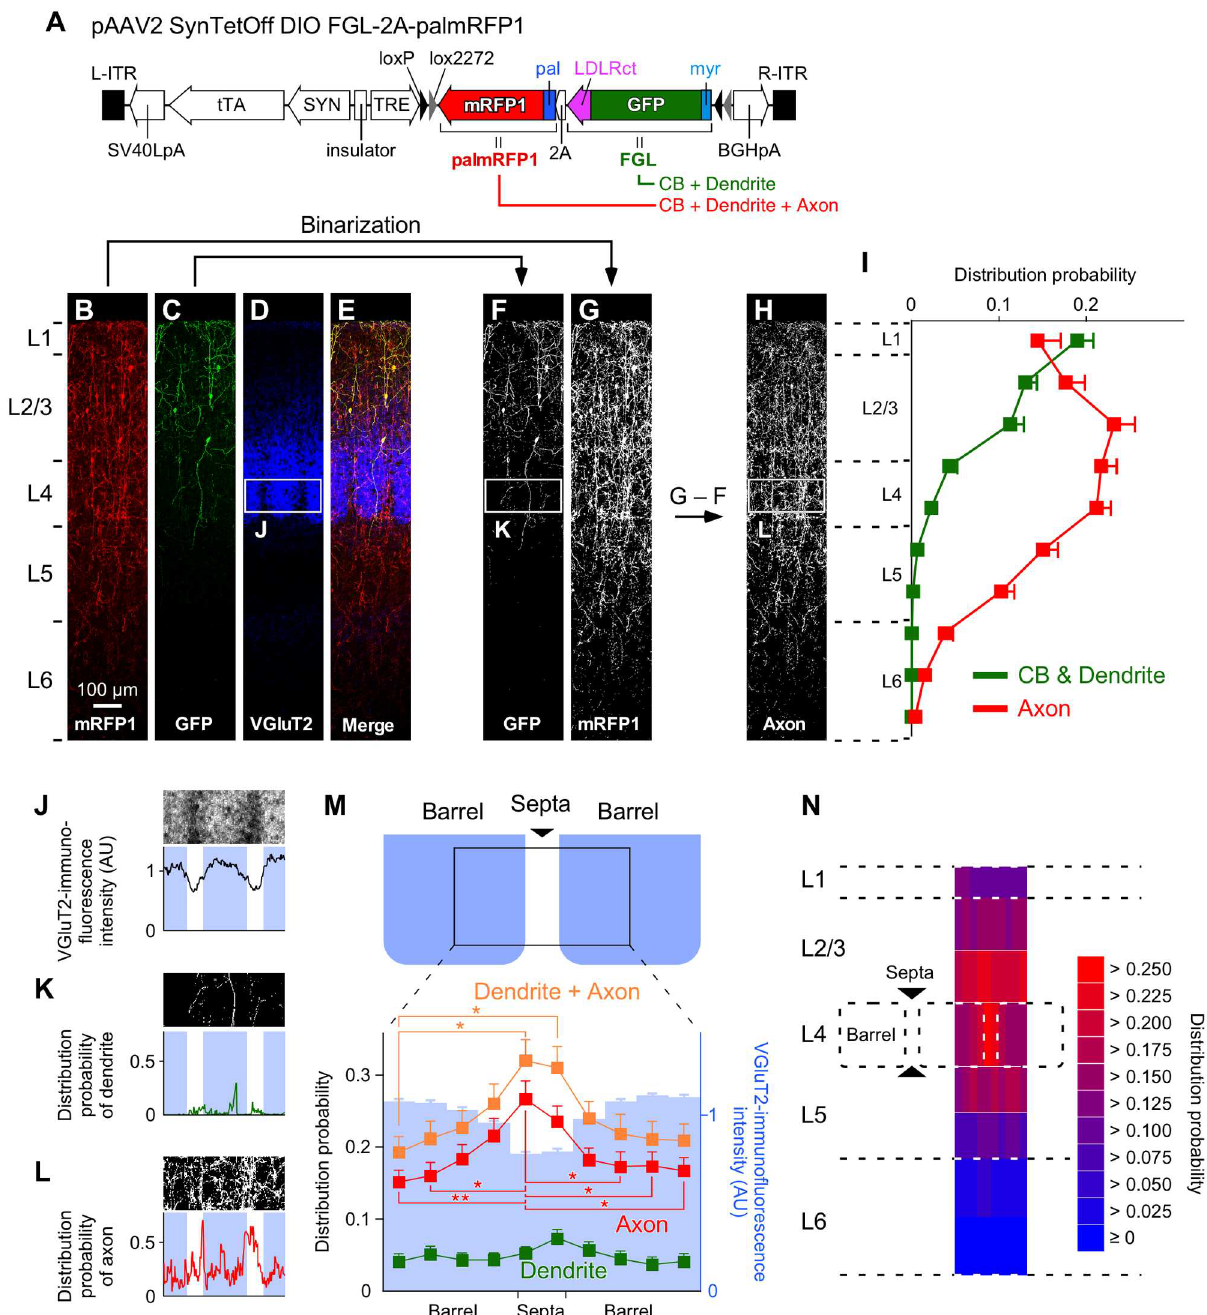
Fig 5. Differential distributions of the dendrites and axons of L2/3 VIP+ neurons in the S1BF. ( A ) Constructionof the vector plasmid, pAAV2-SynTetOff-FLEX-FGL-2A-palmRFP1. ( B–E ) Coronalsections immunostained for mRFP1 (B), GFP (C), and VGluT2 (D). Scale bar in B applies to B–E. ( F , G ) Binarizationof the images for GFP and mRFP1. The binary image of GFP signals(F) represents the somatodendritic distribution of L2/3 VIP+ neurons. ( H ) Axonaldistributionwas estimated by subtractingthe binarizedimage for GFP (F) from that for mRFP1 (G). ( I ) The distributionprobabilities of the somatodendrites and axons of L2/3 VIP+ neuronsacross cortical layers. ( J ) VGluT2-immunofluorescence intensity in the tangentialdirection in L4 of the S1BF. Blue indicatesbarrel locations.( K , L ) The distribution probabilities of the dendrites(K) or axons (L) of L2/3 VIP+ neuronsin L4 of the S1BF. ( M ) Mean distribution probabilities of the dendrites and/or axons of L2/3 VIP+ neuronsin L4 of the S1BF. The probabilities are plotted betweenthe centers of adjacent barrels. The tangential width was dividedinto 10 bins. Blue bars represent VGluT2 immunofluorescenceintensities. ( N ) Axonaldistributionsof L2/3 VIP+ neuronsin the S1BF. The vertical widths of L2/3, L5, and L6 were dividedby a factor of 2 at the center of each layer. The distributionprobabilityof the